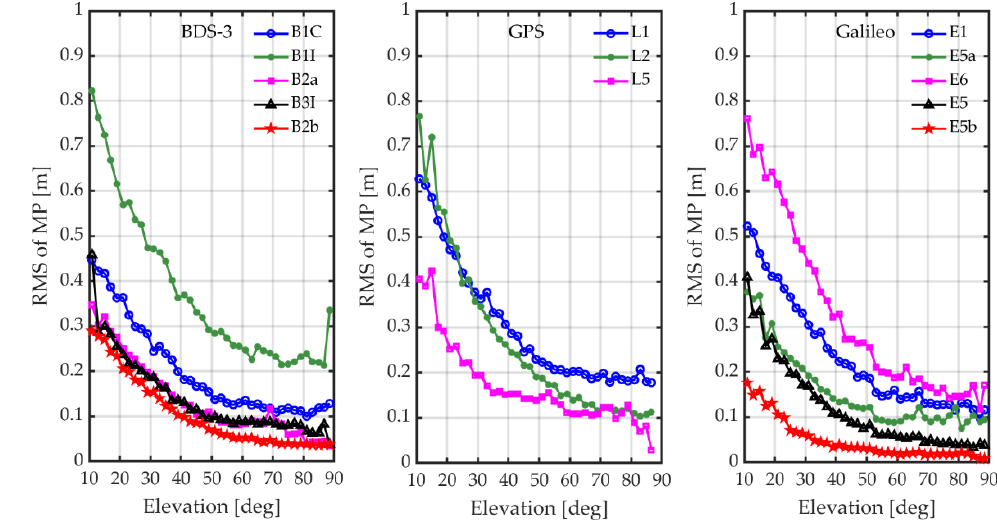
Figure 2. Root mean square (RMS) of multipath (MP) vs. elevation angle of all the observed signals in BDS-3, GPS, and Galileo. The RMS of MP of every 2° of elevation of all the signals were computed with the whole constellation that can be tracked.